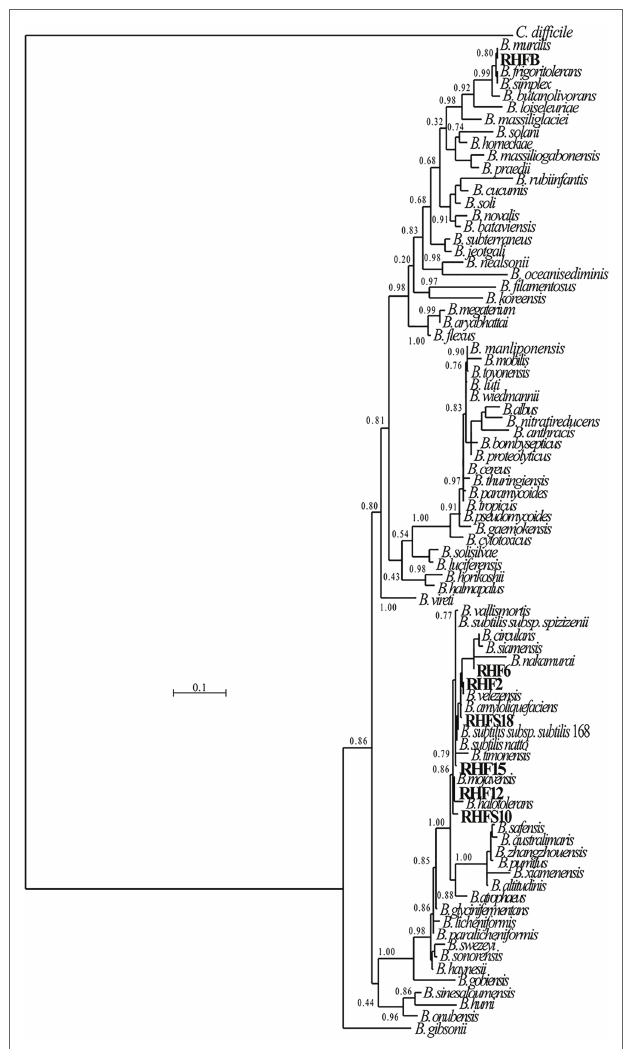
FIGURE 1 | Phylogenetic tree of the spore-forming bacteria isolated from salt-pans. The phylogenetic tree was constructed using the Maximum- likelihood algorithm with model GTR + I + G4, based on 16S rRNA gene sequences. The gene sequences of the isolated bacteria were aligned to reference bacteria belonging to the Bacillaceae family according to Genome Taxonomy Database (GTDB). Node support represents the approximate likelihood-ratio test (aLRT) and is shown at the corresponding node of the tree. Clostridium difficile is used as an